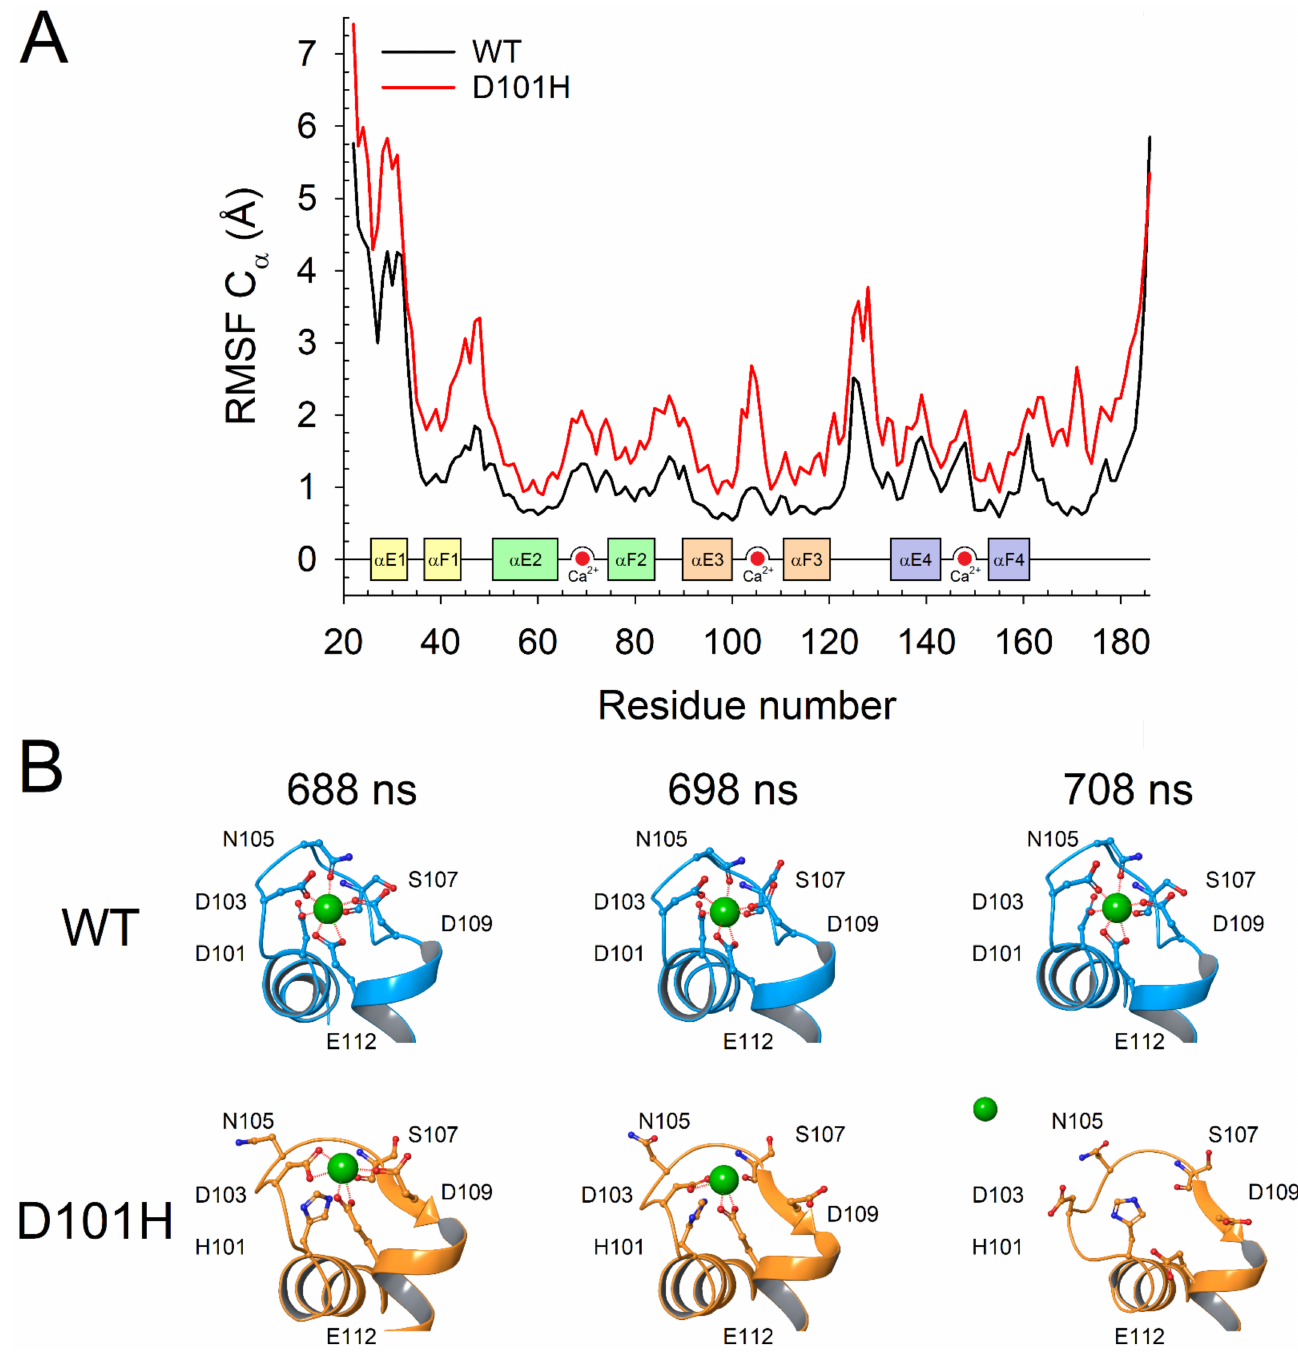
Figure 9. ( A ) Root–Mean Square Fluctuation (top panel) of C α atoms calculated over 2 µ s molecular dynamics (MD) simulations of Ca 2+ -loaded nmWT (black) and nmD101H (red) GCAP3. Inset shows secondary structure elements colored according to Figure 1, Ca 2+ -ions are represented as red circles. Snapshots of the Ca 2+ -binding EF3 motif ( B ) from 2 µ s MD simulations of nmWT (blue) and nmD101H (orange) GCAP at three different time-frames; protein structure is shown in cartoon, Ca 2+ ion is represented as a red sphere, Ca 2+ -coordinating residues D/H101, D103, N107, S107, D109 and E112 are labelled and depicted as sticks with N atoms in blue and O atoms in red, zero-order bonds with the Ca 2+ -ion are shown as dashed red